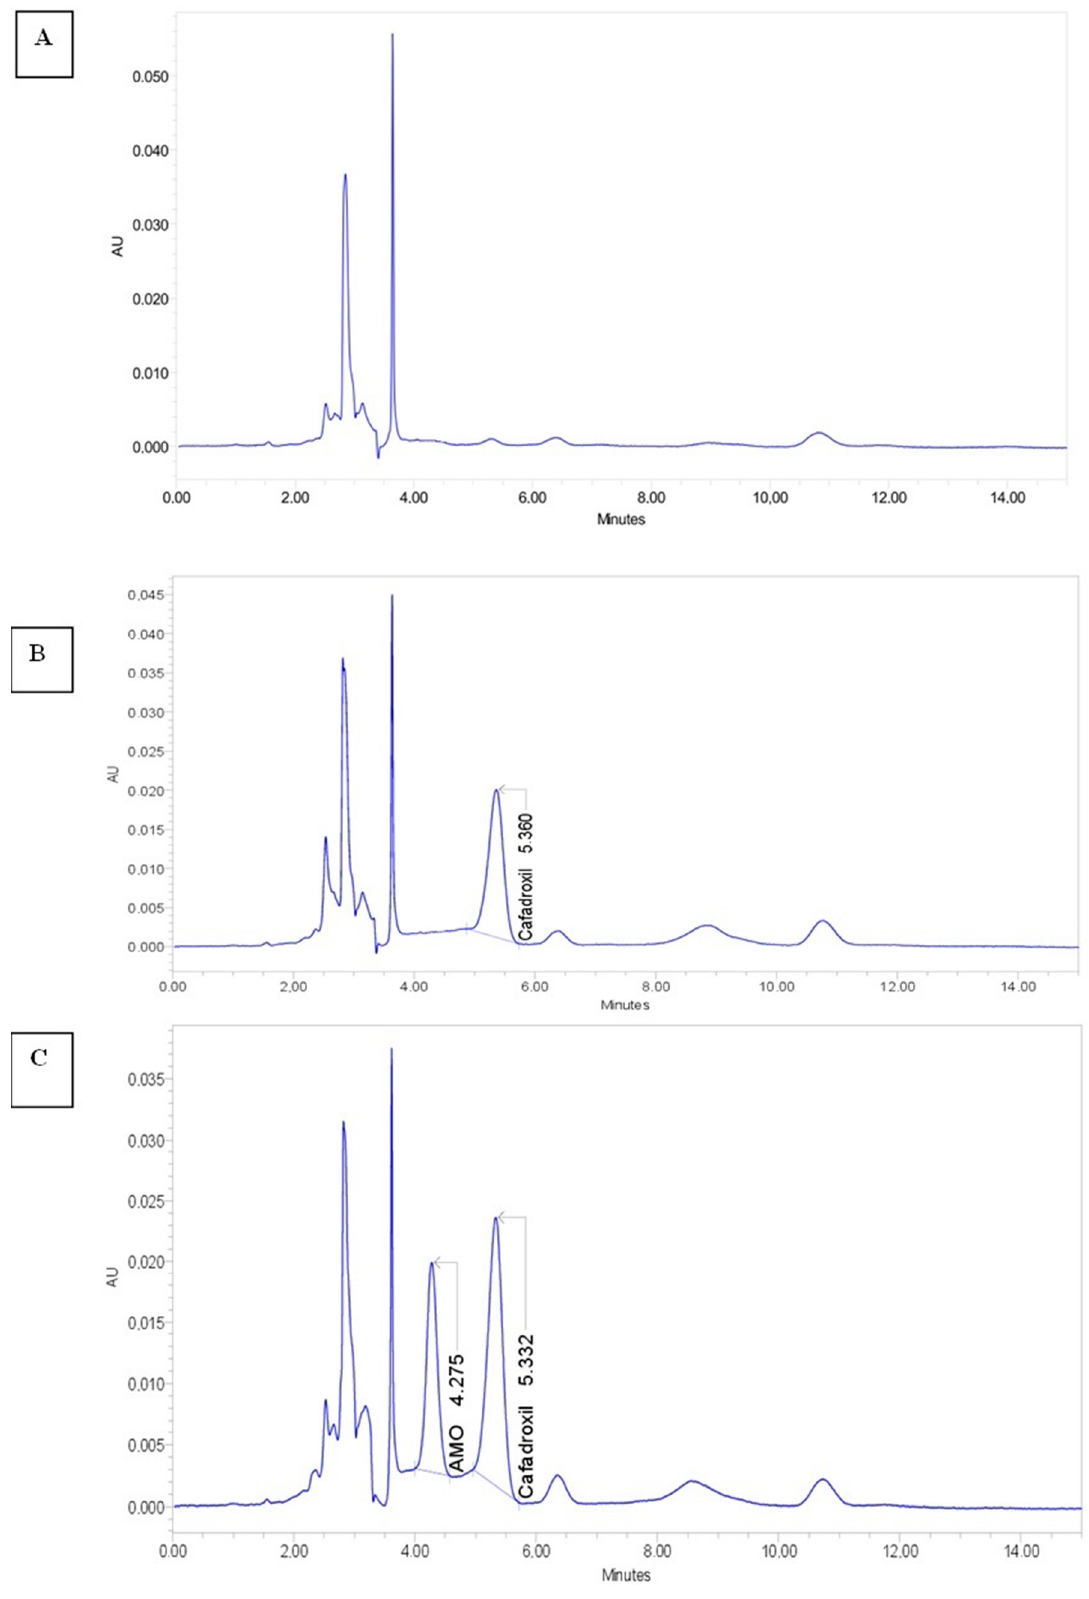
Figure 1. Chromatographic analysis of AMX: ( A ) plasma blank; ( B ) plasma + internal standard (cefadroxil 20 µg/mL); ( C ) plasma + AMX (10 µg/mL) + internal standard (cefadroxil 20 µg/mL).